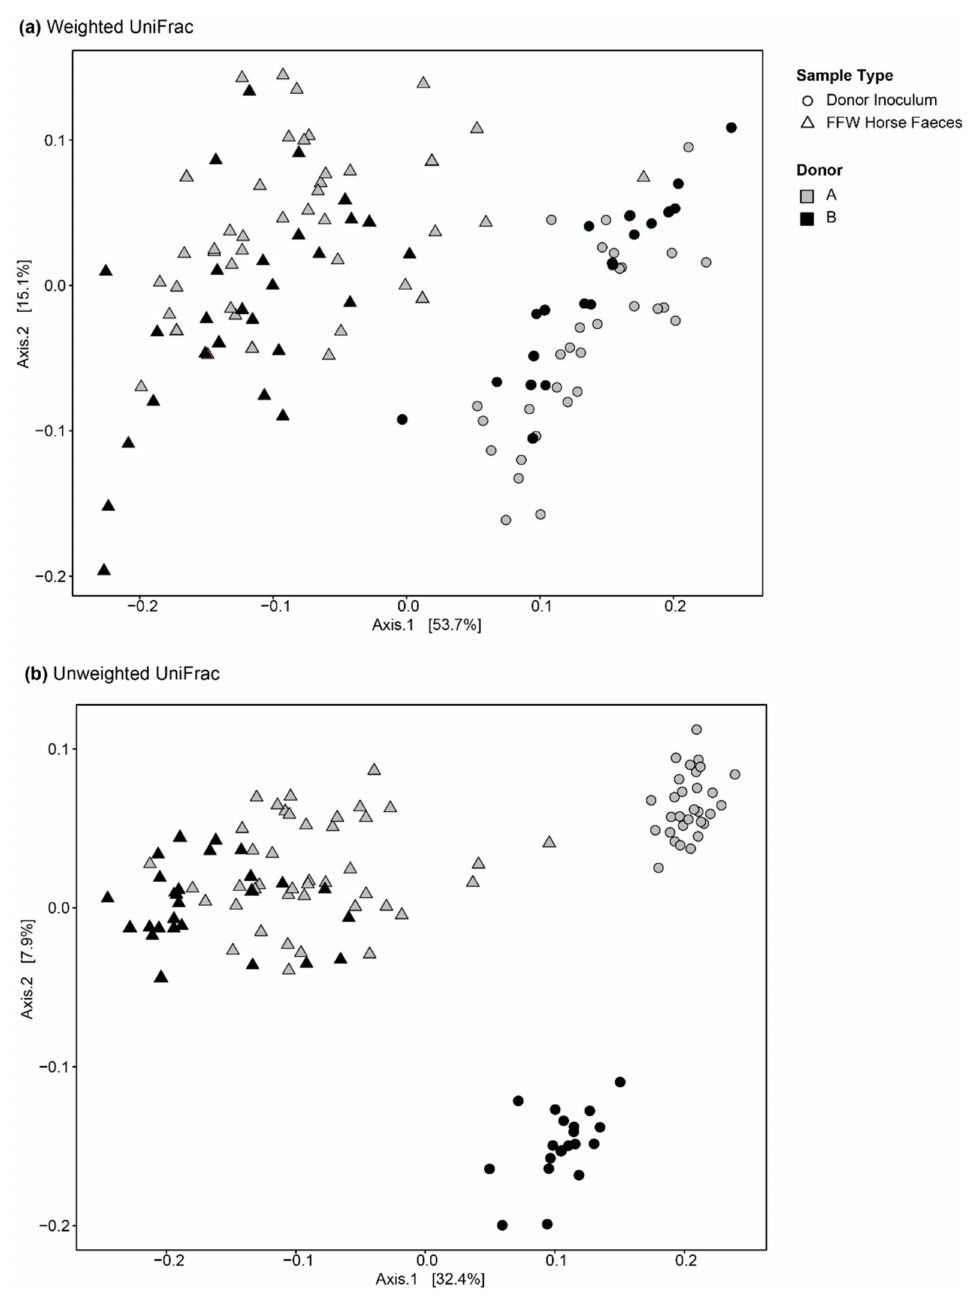
Figure 7. PCoA plots of 16S rRNA gene-based prokaryotic community composition data from faecal microbiota of the FFW horses (before and after FMT, i.e., seven samples per FFW horse) and the donor inocula they were treated with (i.e., five samples per FFW horse). Analysis was performed with both weighted ( a ) and unweighted ( b ) UniFrac distances. In the plots, the shape of the symbols indicates whether the sample is donor inoculum or FFW horse faeces. The symbol colour indicates the donor animal that the sample was associated with (i.e., which animal the inoculum was prepared from or, in the case of the FFW horse faeces, the animal that received